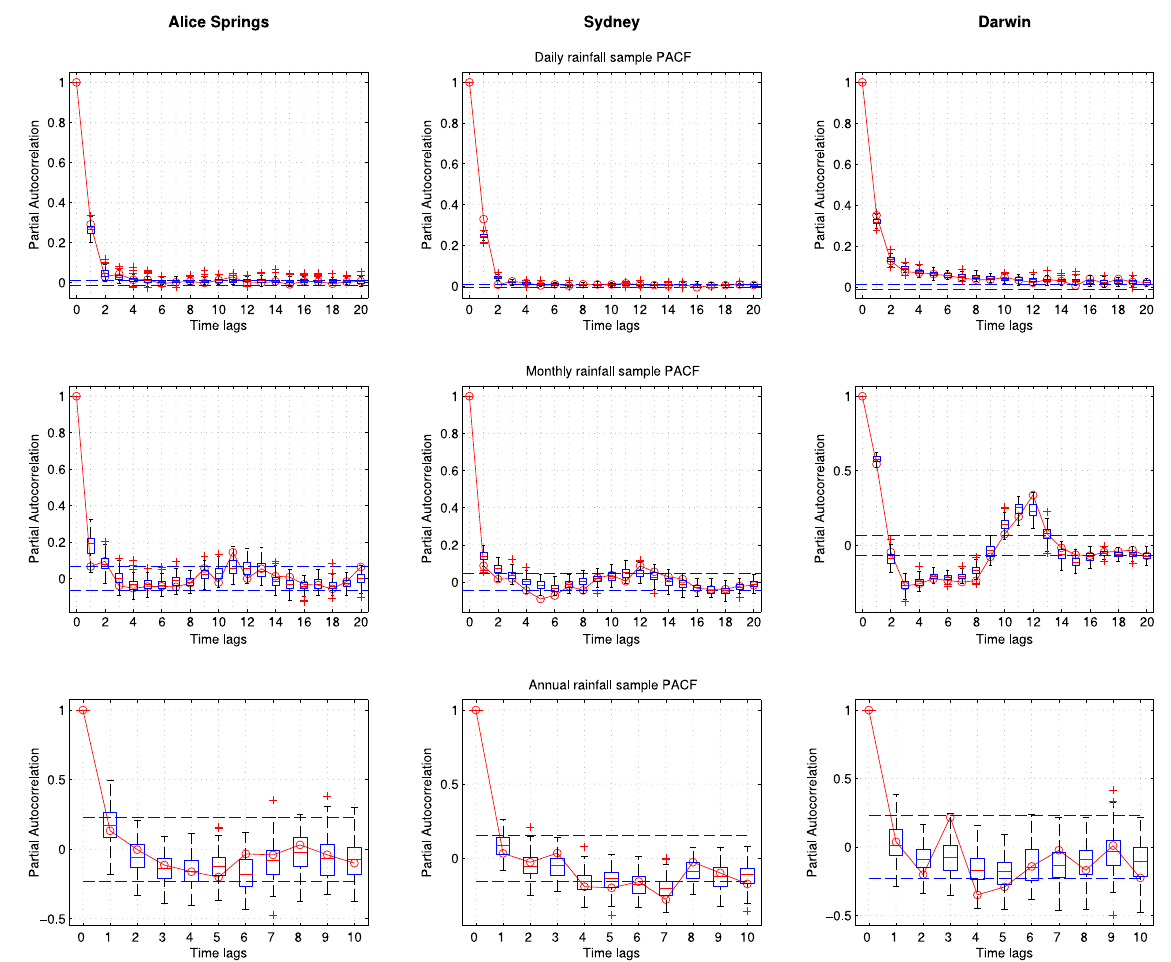
Figure 8. Sample PACF of the daily, monthly and annual rainfall signal. Reference (solid line), 100 DS simulations (box plots), and confi- dence bounds for the negligible autocorrelation indexes (dashed lines).